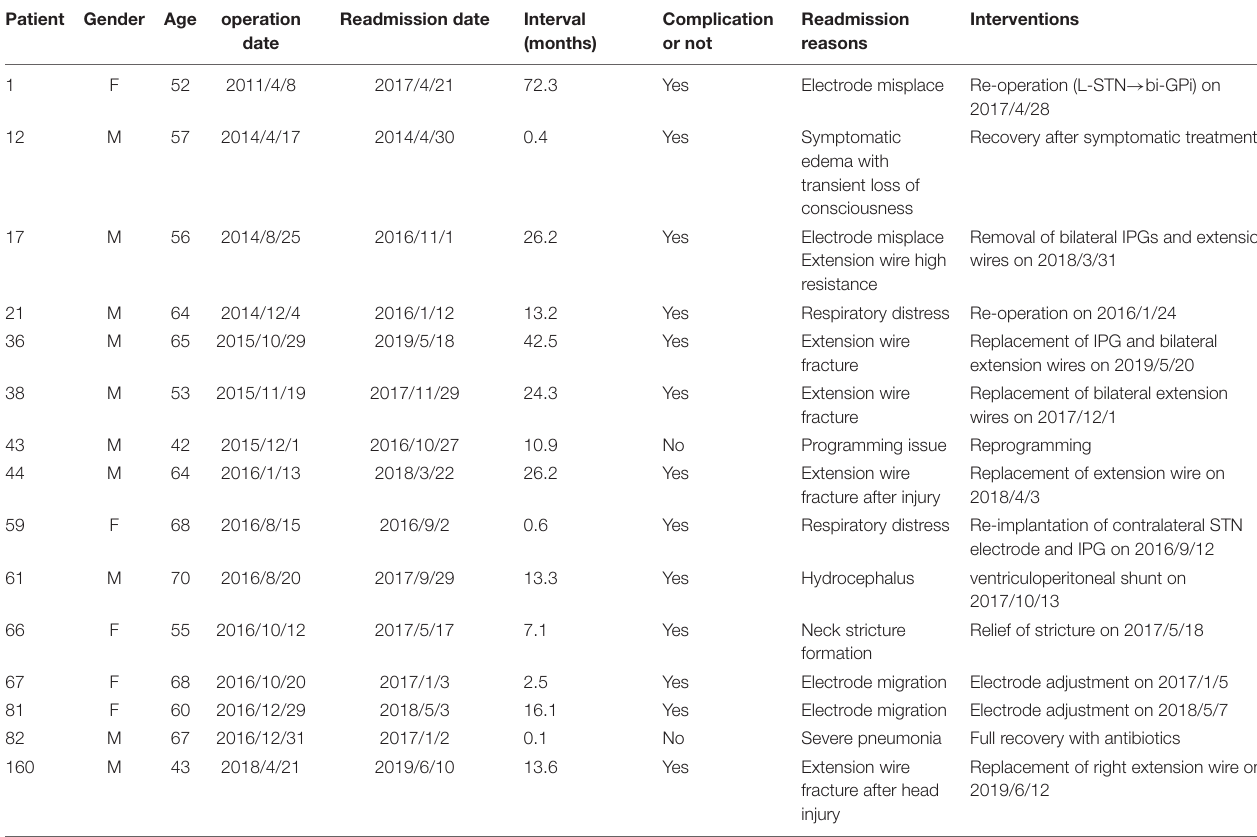
TABLE 4 | Causes for Unplanned Readmission and Interventions. Patient Gender Age operation